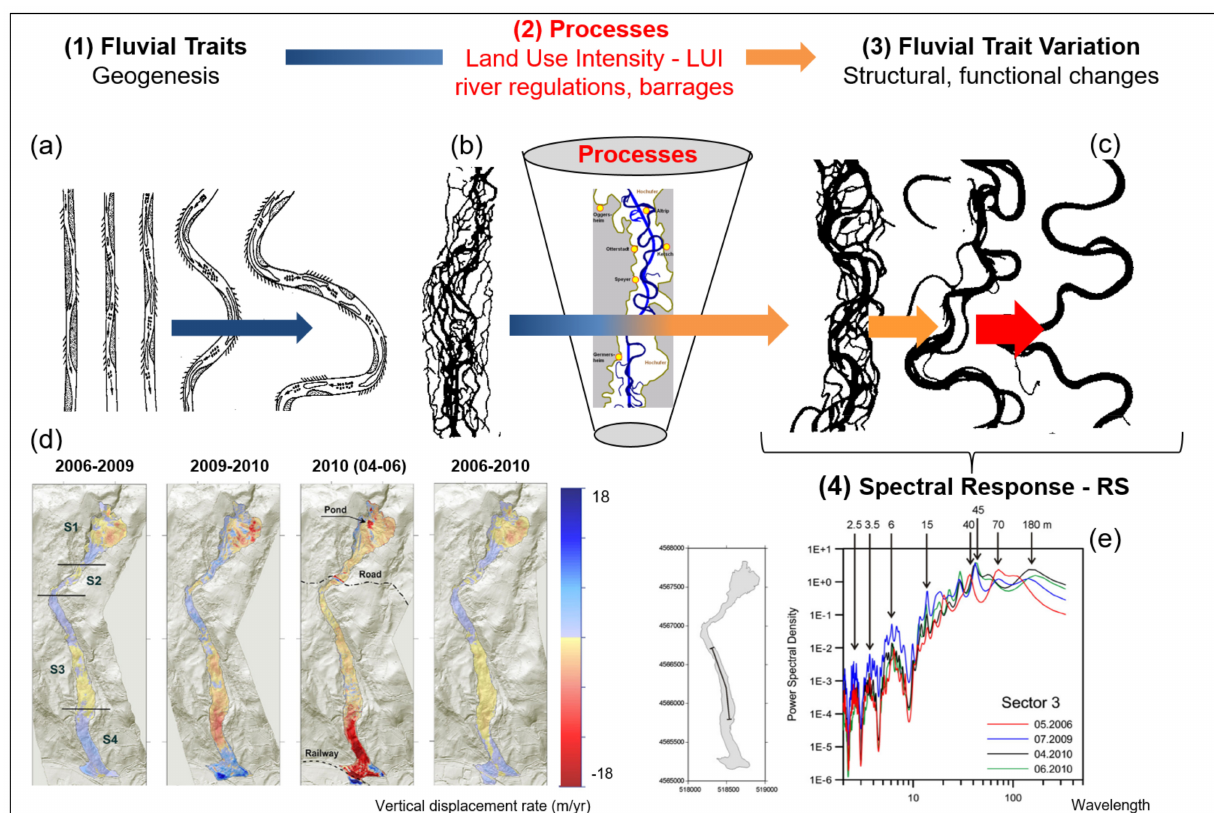
Figure 14. Monitoring status and changes to geomorphic characteristics with RS. ( a ) Different pro- cesses during geogenesis lead to the formation of specific morphometric fluvial traits—the meanders, ( b ) the entire river system is characterized by these meanders. (2) Processes/drivers such as land-use- intensity, river regulations, or barrages lead to ( c ) changes in structural, functional fluvial traits (fluvial trait variations) ( d , e ). These fluvial trait variations lead to spectral responses in the remote sensing signal ( d ). Example of monitoring temporal changes of fluvial traits—vertical displacement rate of the river system from 2006–2010 with remote sensing technologies (LiDAR) ( d , e ). From Ventura et al. [99], Reprinted with permission from Ventura et al. [99], 2021, Elsevier. license no.